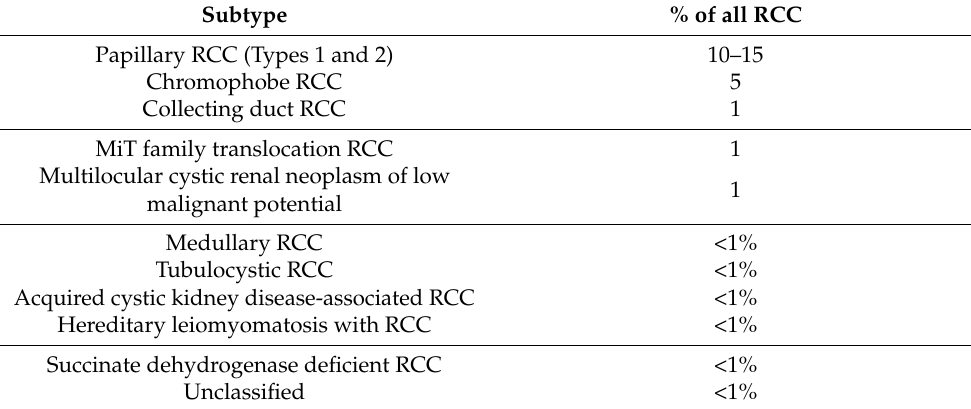
Table 1. Incidence of RCC subtypes